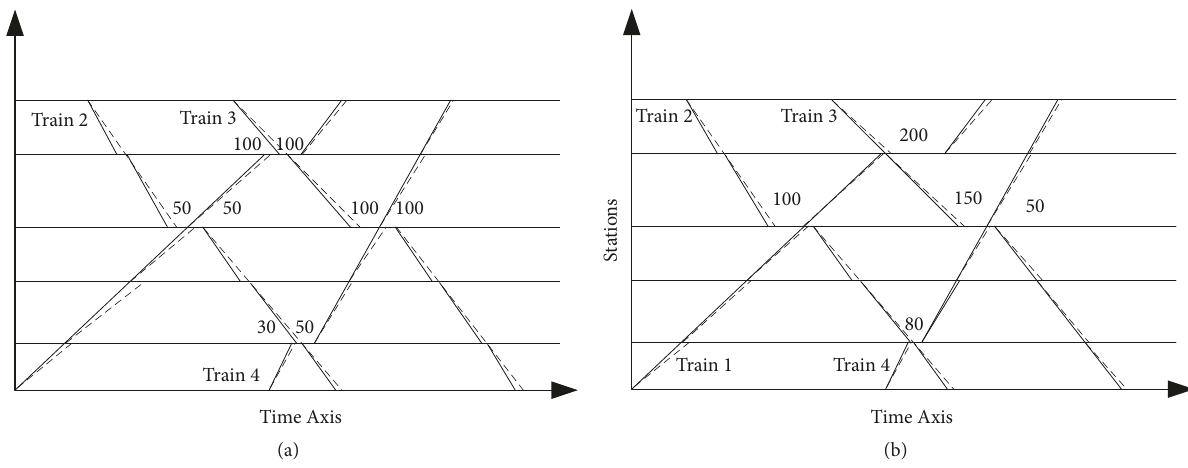
Figure 2: Two alternative train timetables with the same amount of buffer